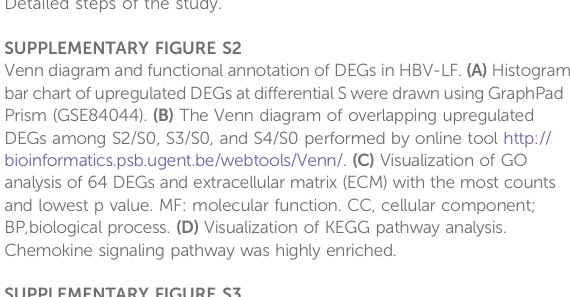
and lowest p value. MF: molecular function. CC, cellular component; BP,biological process. (D) Visualization of KEGG pathway analysis. Chemokine signaling pathway was highly enriched. SUPPLEMENTARY FIGURE S3 ValidationofGSassociatedhubgenesinHBV-LFandCHB. (A-C) Volcano